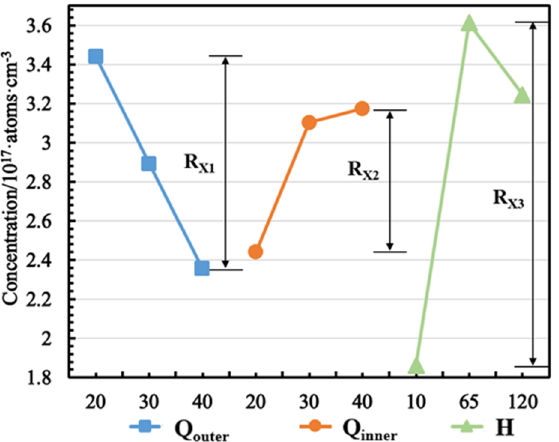
Figure 5. The influence of various levels of factors on C impurity indicators.